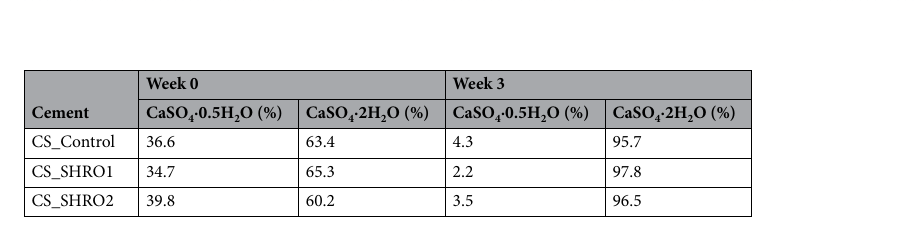
Table 2. Overview of cement composition as prepared (Week 0) and following 3 weeks of static ageing in distilled water (Week 3).